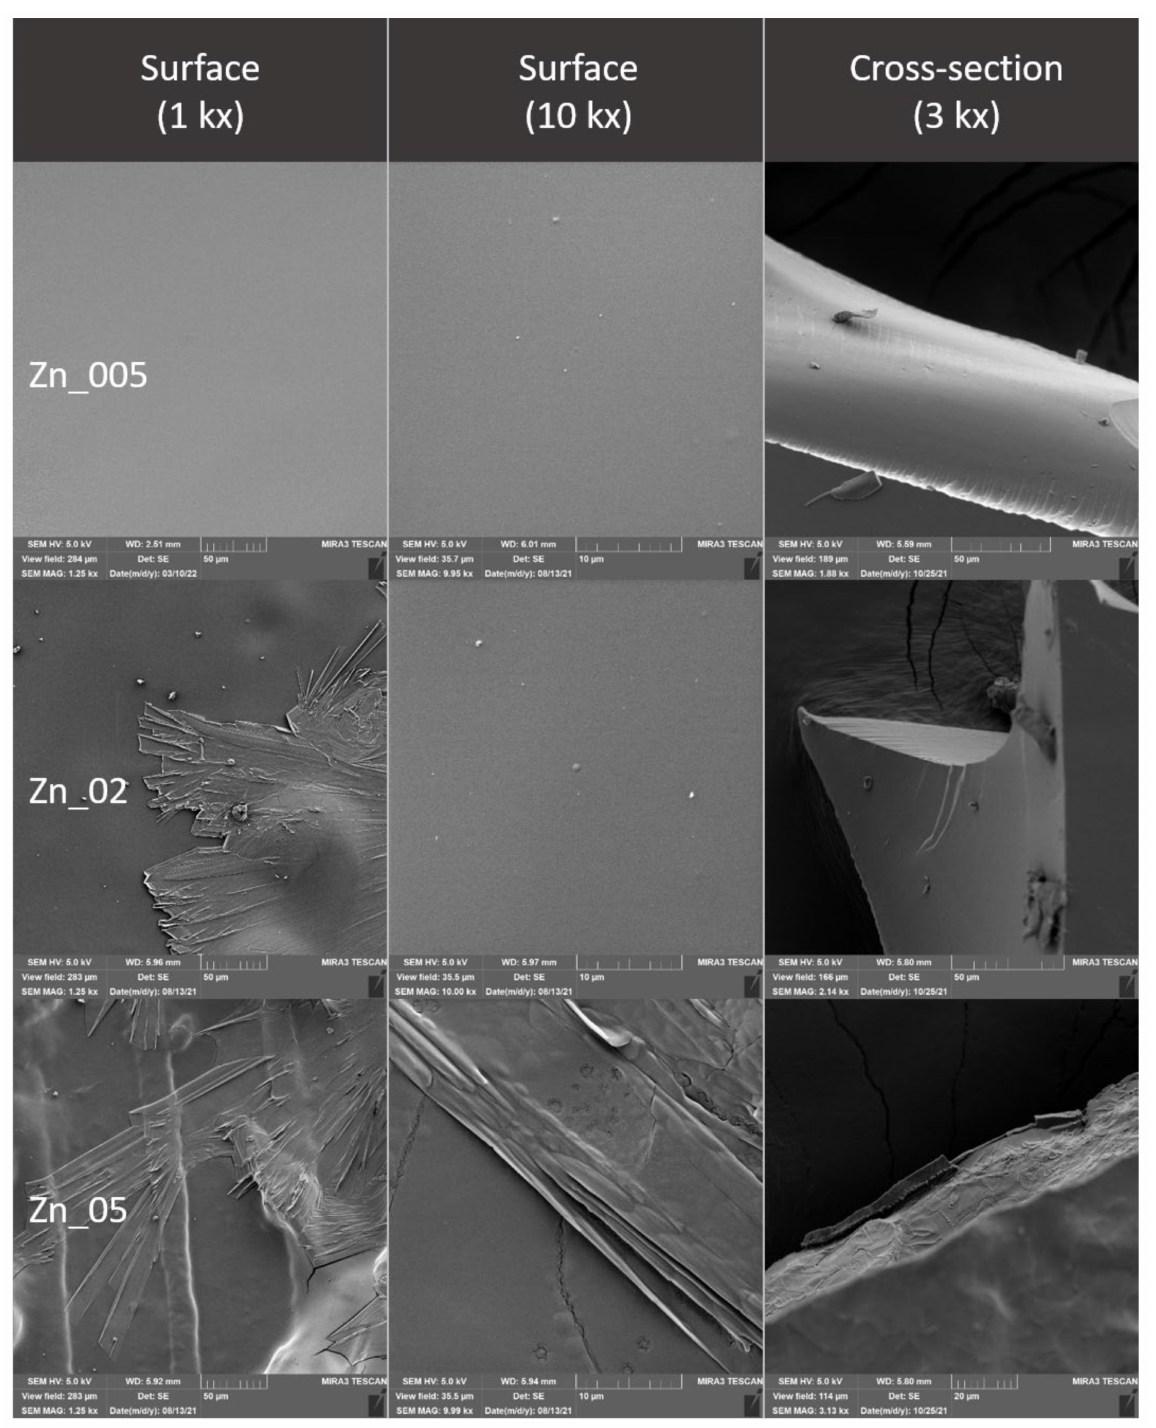
Figure 13. Surface and fracture microstructure of edible packaging with the addition of ZnO